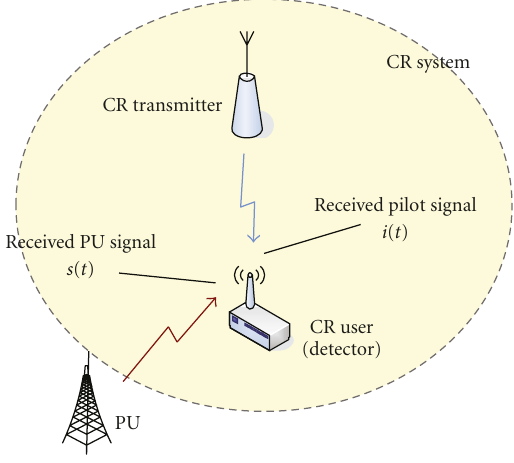
Figure 1: PU detection without quiet